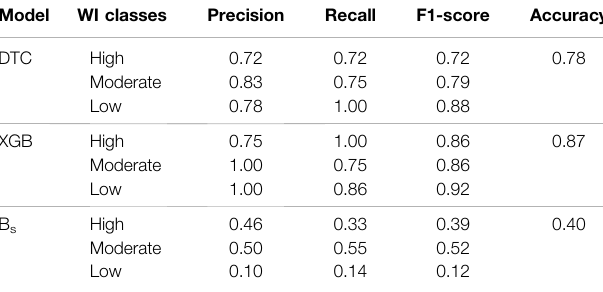
TABLE 6 | Model performance goodness of the last week.